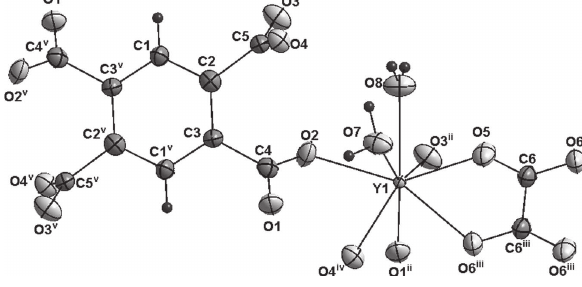
Table 1: Data collection and handling.